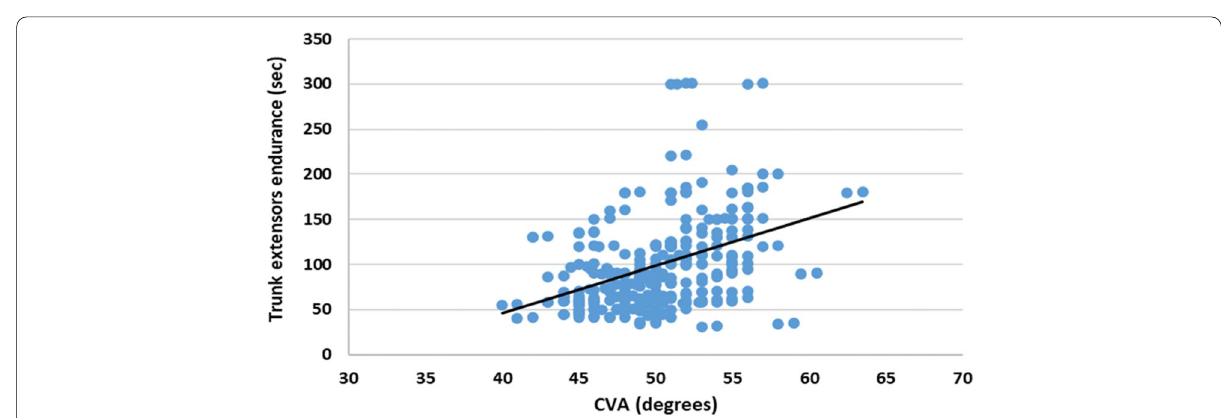
Fig. 3 Correlation between CVA and trunk extensor endurance in the study group